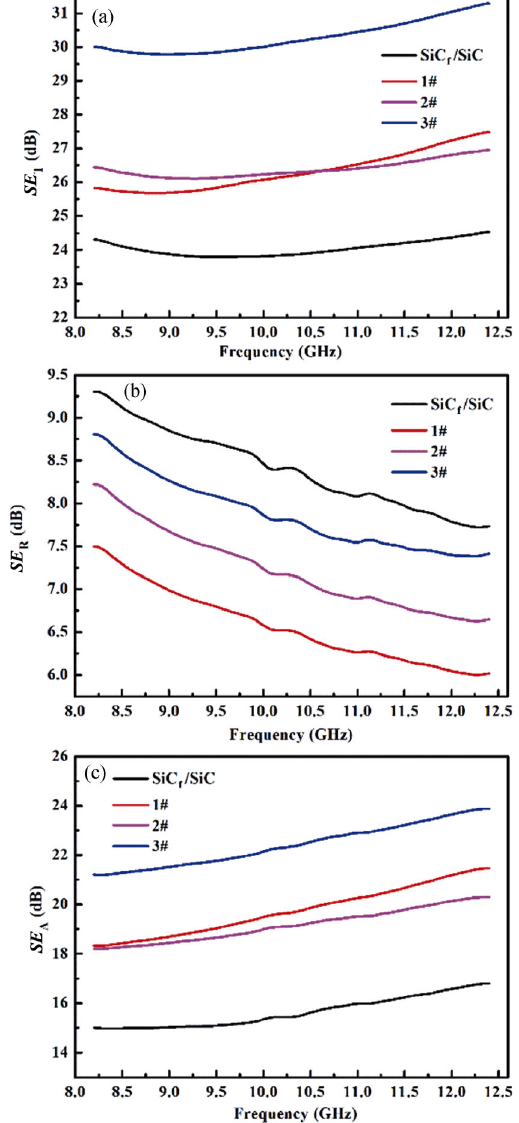
Fig. 9 Shielding effectiveness of as-fabricated composites: (a) SE T , (b) SE R , and (c) SE A